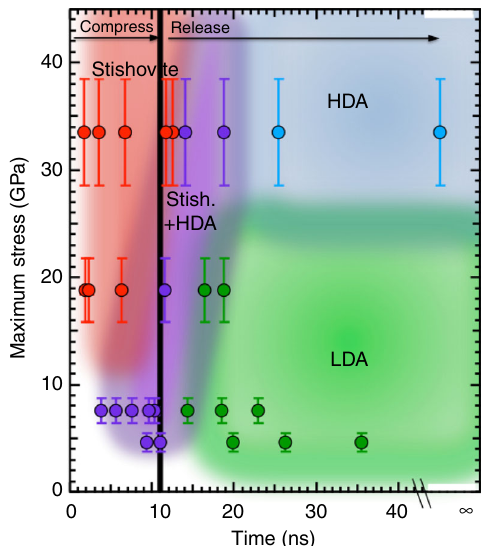
Fig. 4 Reaction diagram of SiO 2 under shock compression. Metastabilty phase diagram showing peak pressure phase as a function of time from compression and release path. Colored area approximately cluster similar phases to show pressure (and associated shock temperature) — time boundaries. Stress error bars are determined from velocimetry and include scatter in the measured transit times, uncertainty in the total sample thickness, uncertainty in the pressure-irradiance scaling law